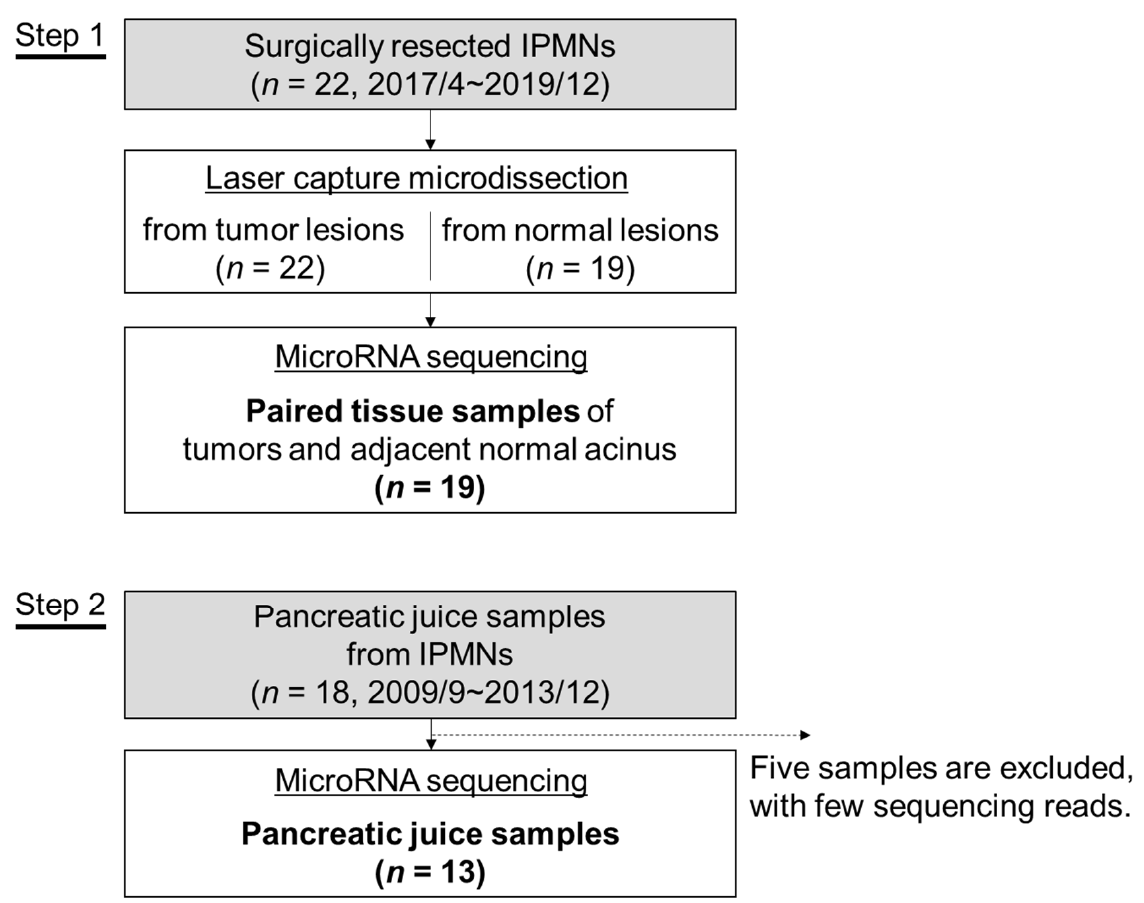
Figure 5. A flowchart of the study. The microRNA expression in intraductal papillary mucinous neoplasm (IPMN) was analyzed in tissue samples (Step 1) and pancreatic juice samples (Step